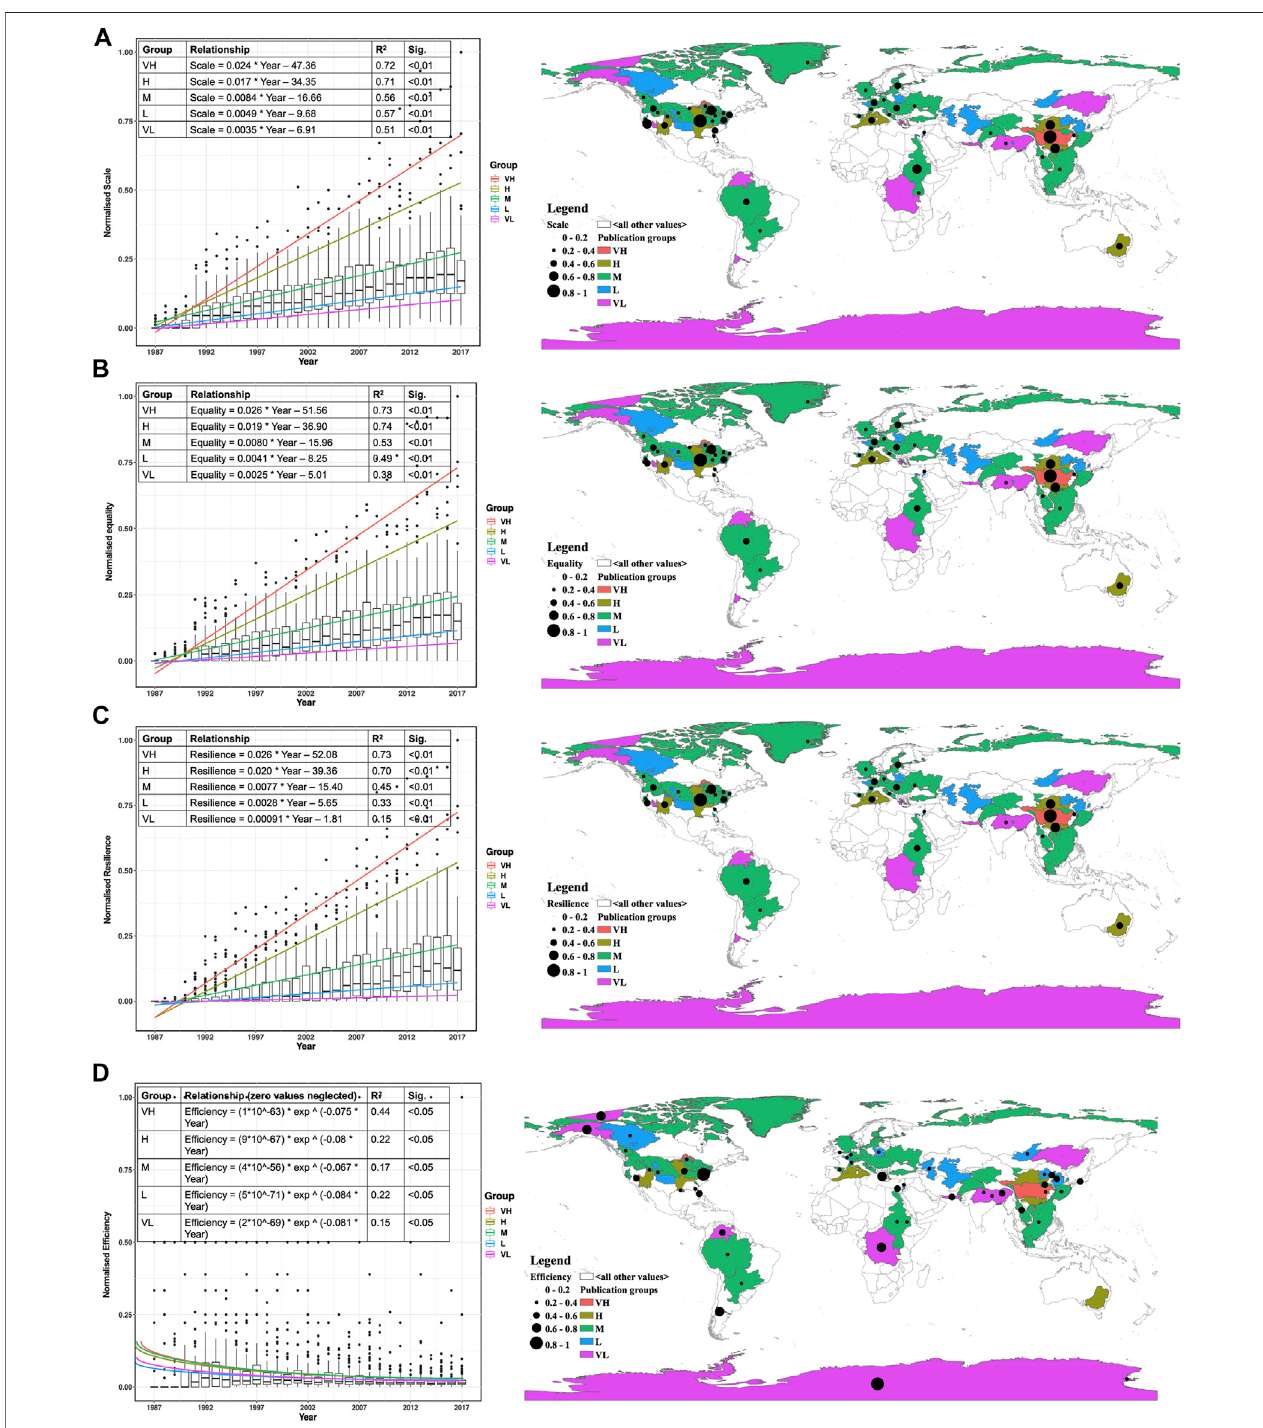
FIGURE2| Temporalevolutions(left)andspatialdistributions(right)ofthe (A) scale, (B) equality, (C) resilience,and (D) ef fi ciencyamongthe fi vepublicationgroups during 1987 – 2017.